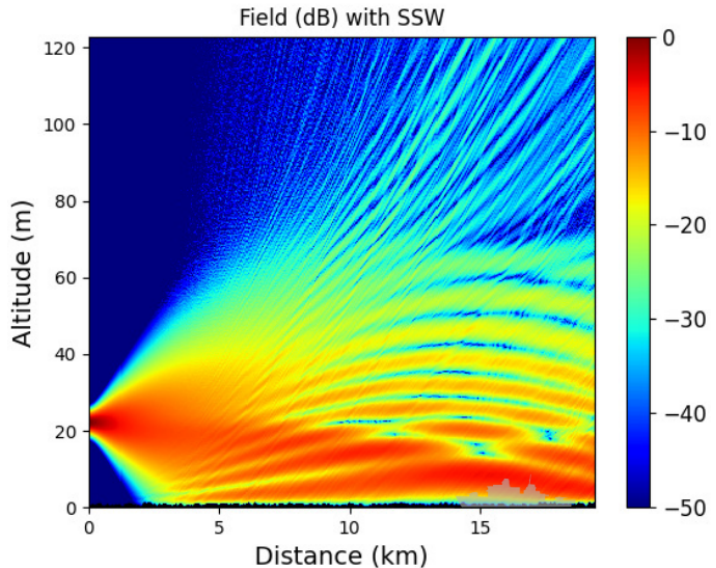
Figure 14. Mean reduced field over 50 Monte-Carlo simulations computed with the SSW method. In this case the source is placed z s = 20 m above the